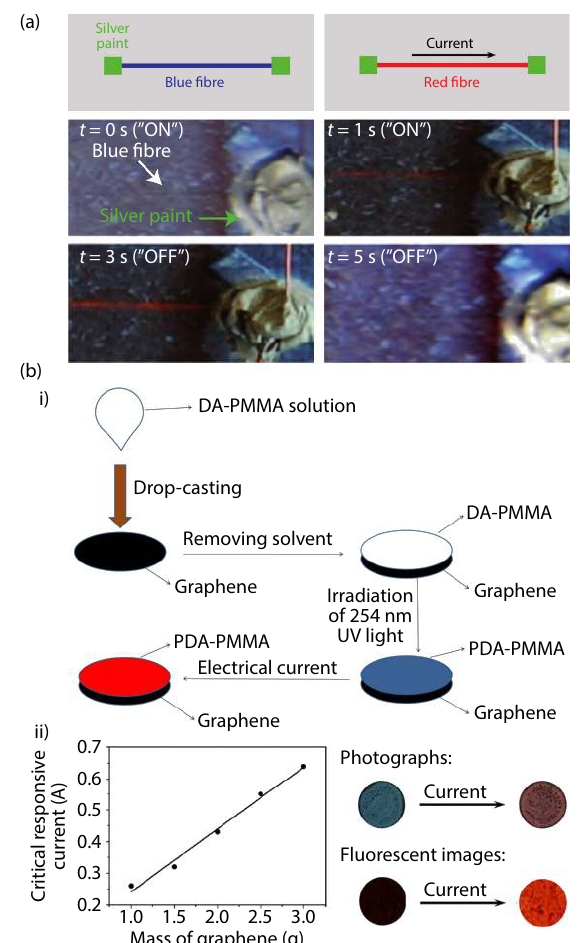
Fig. 12 Current-induced color transition phenomena of chemosensors based on PDAs. ( a ) Chromatic transitions of a composite CNT/PDA fiber in response to an electric current (reproduced with permission from ref. [53], © 2009 Nature Publishing Group). ( b ) Polydiacetylene-polymethylmethacrylate/ graphene composites as an electrical current sensing material. (i) Schematic diagram for the preparation of PDA-PMMA/graphene composites followed by the electrochromic process. (ii) Relationship between the critical responsive current and the graphene content. (iii) Photograph and fluorescent image for PDA-PMMA/graphene composites before and after a current stimulus. Repro- duced with permission from ref. [183], © 2013 American Chemical